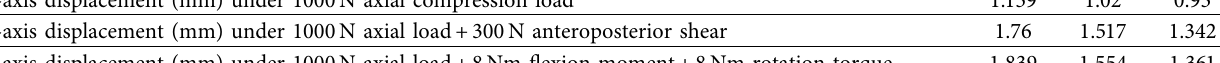
Table 1: Bionate ® nucleus replacement properties comparing the three types of this material. We shaded the maximum results in blue. Nucleus replacement data with Bionate